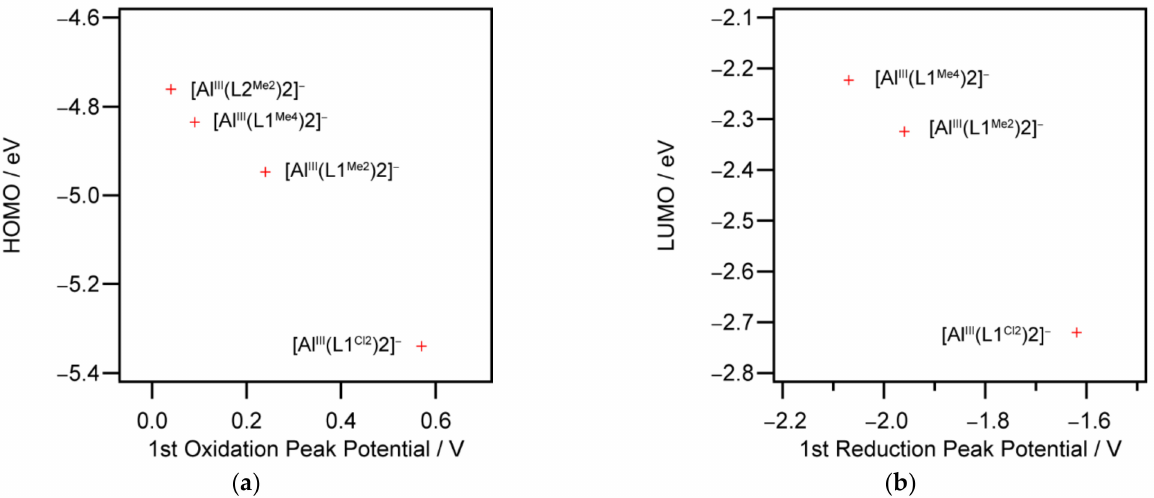
Figure 6. The correlation plots between the HOMO and the first oxidation peak potential ( a ) and between the LUMO and the first reduction peak potential ( b